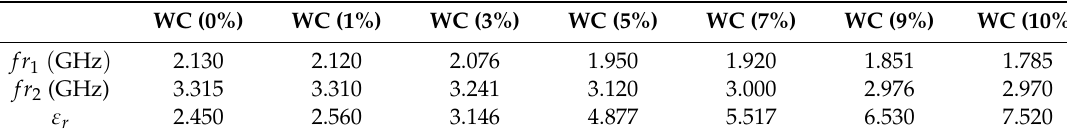
Table 5. Measured results for quartz sand soil samples.